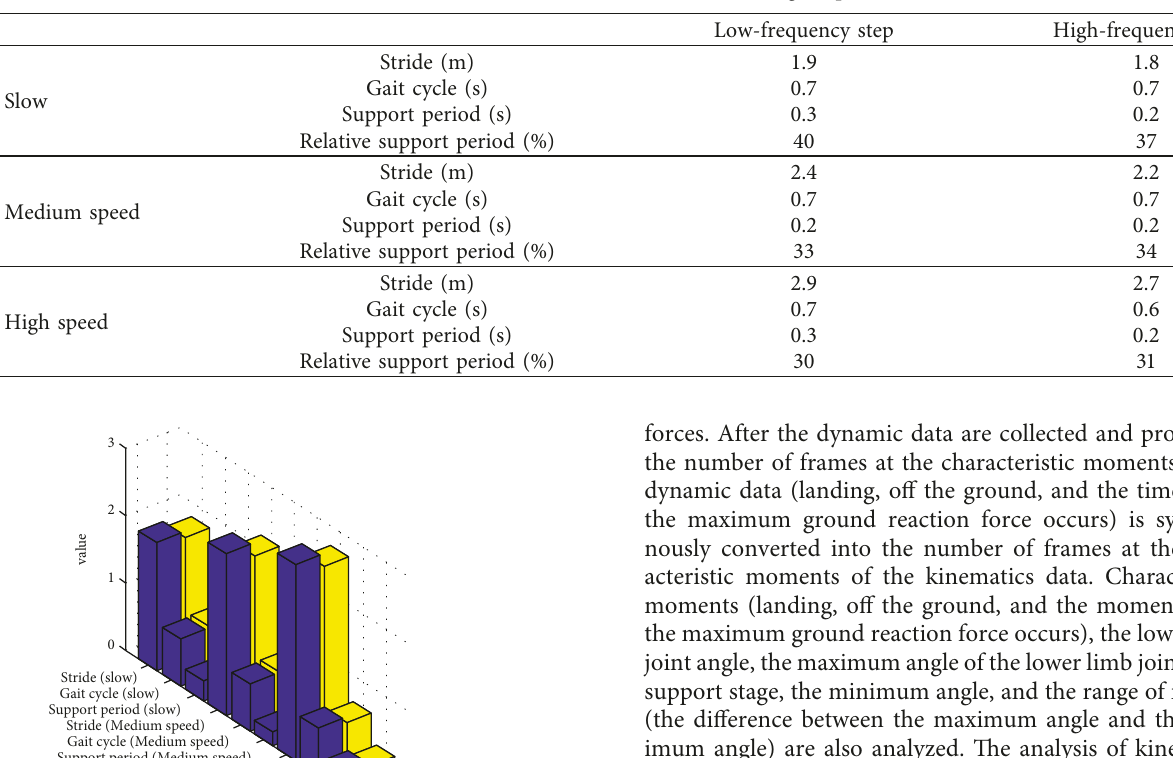
Table 1: Kinematic indicators at different running frequencies.